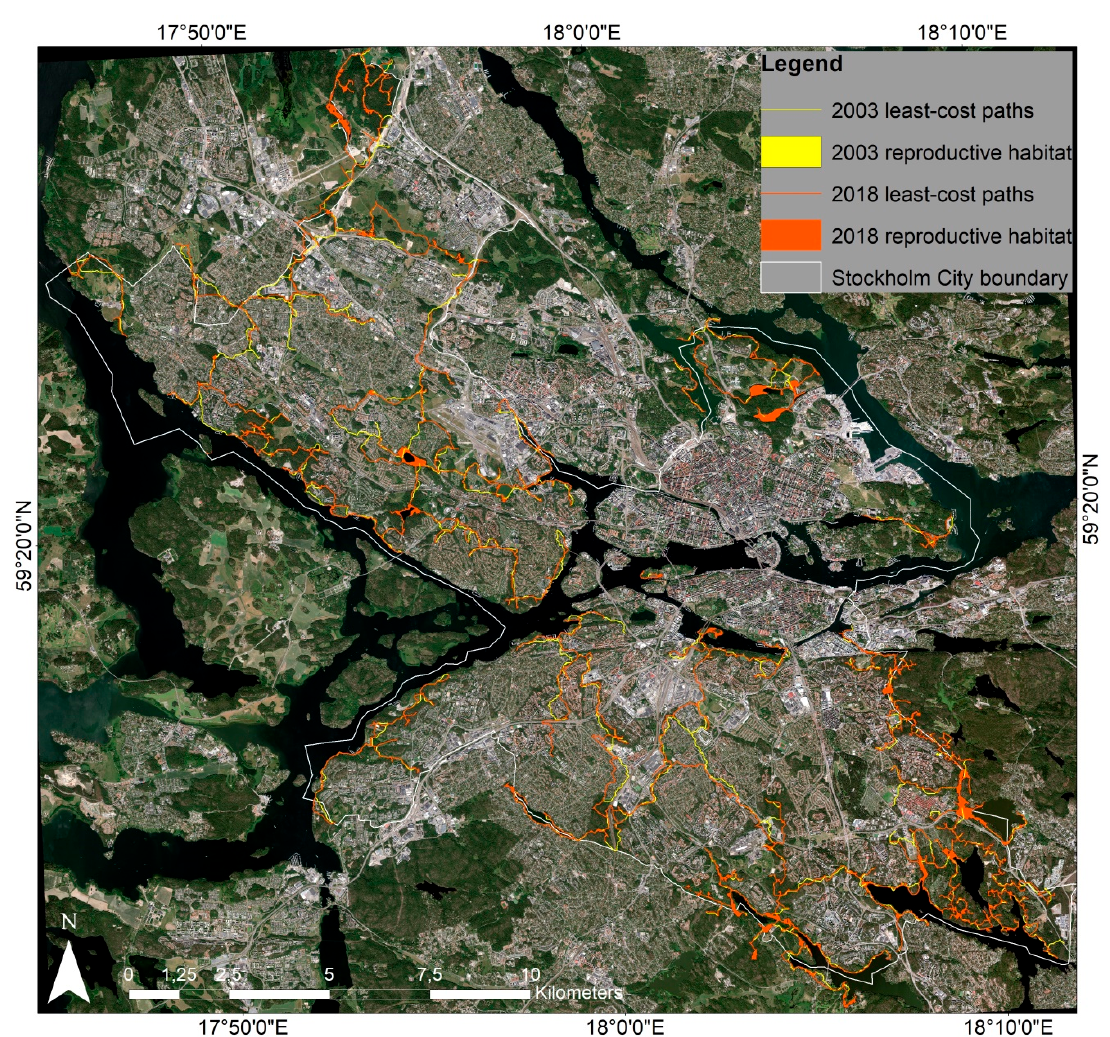
Table 6. Values of the PC index, ECA and percentage changes in total habitat area (dA) and ECA (dECA) for the 2003 and 2018 common toad habitat networks.